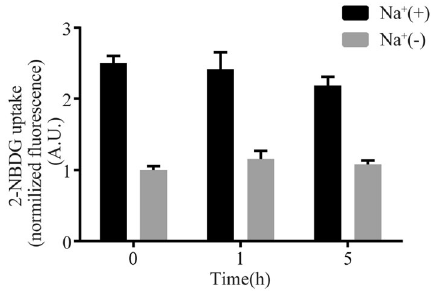
Fig. 4 Effects of Starving HK-2 cells on glucose uptake. HK-2 cells were incubated in DMEM without glucose for 0, 1 and 5 h, then 2-NBDG uptake assay was performed in Na ? ( ? ) or Na ? ( - ) buffer. The uptake values were normalized to the fluorescence intensity of Na ? ( - ) group without starvation. Experiments were performed in triplicate and data are expressed as mean ± S.E.M of three indepen- dent